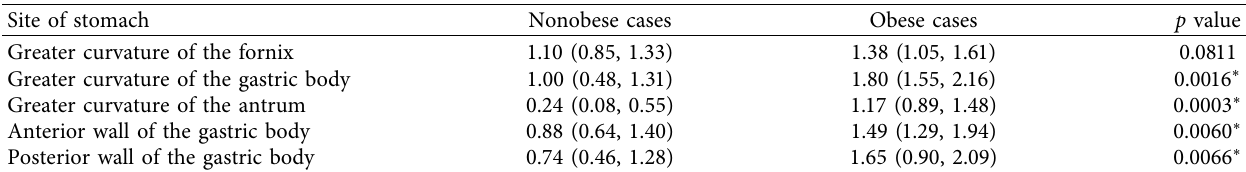
Note. Data are expressed as a median (25th percentile and 75th percentile), ∗ p < 0 .